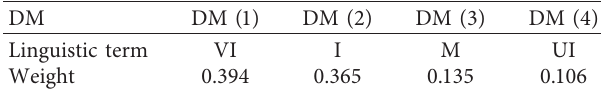
Table 4: The ratings of the alternatives for ϖ Supp.